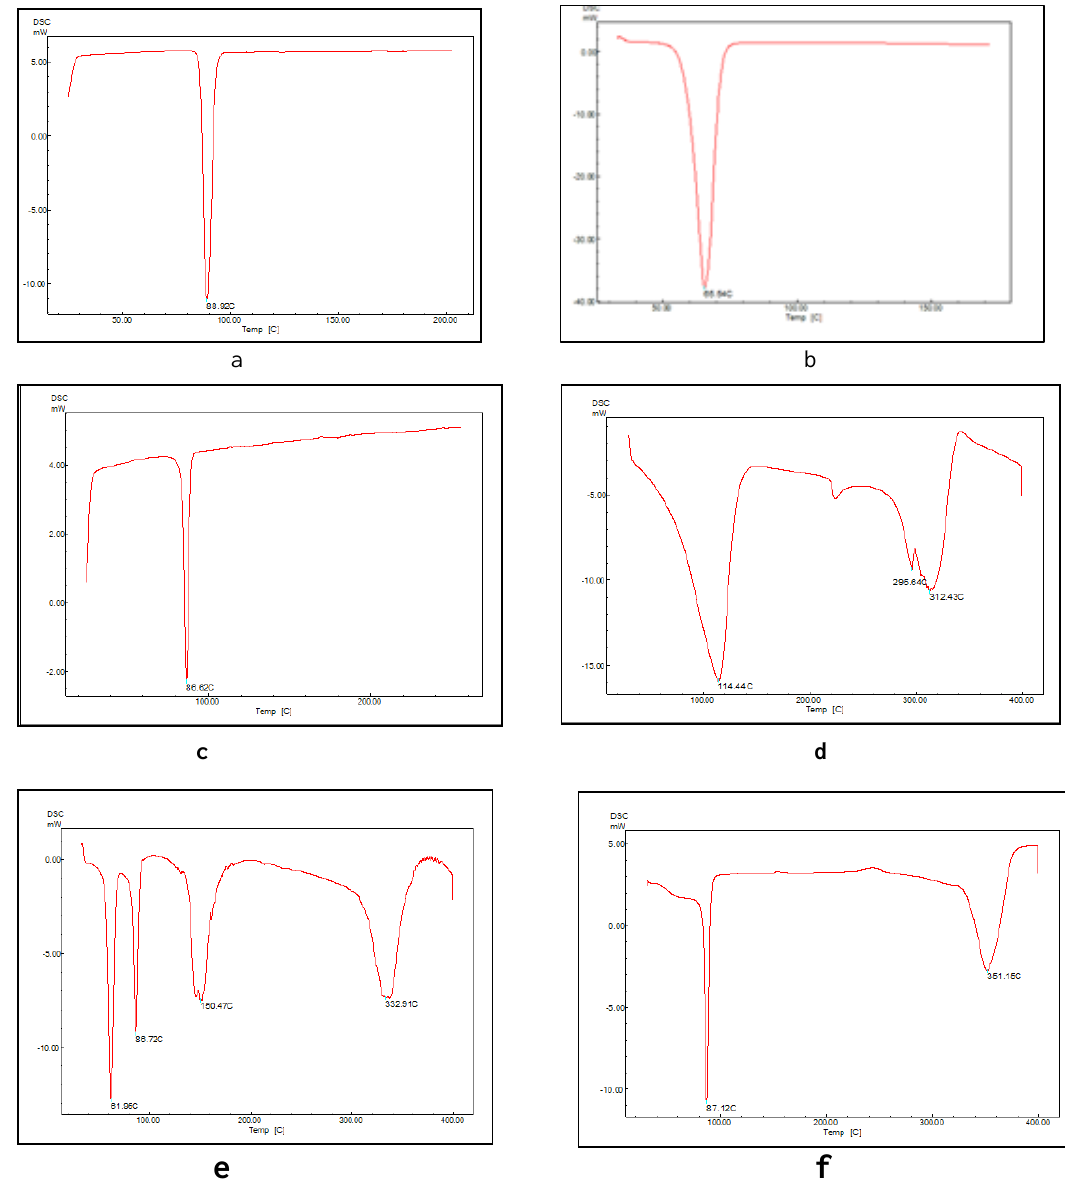
Figure 8. DSC analysis of ( a)EBS, (b)PEG4000 (c) β.cyclodextrin, (d)EBS1, (e)PM,